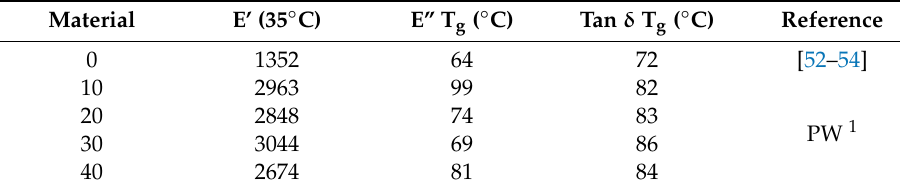
Table 7. Dynamic mechanical analysis (DMA) parameters.